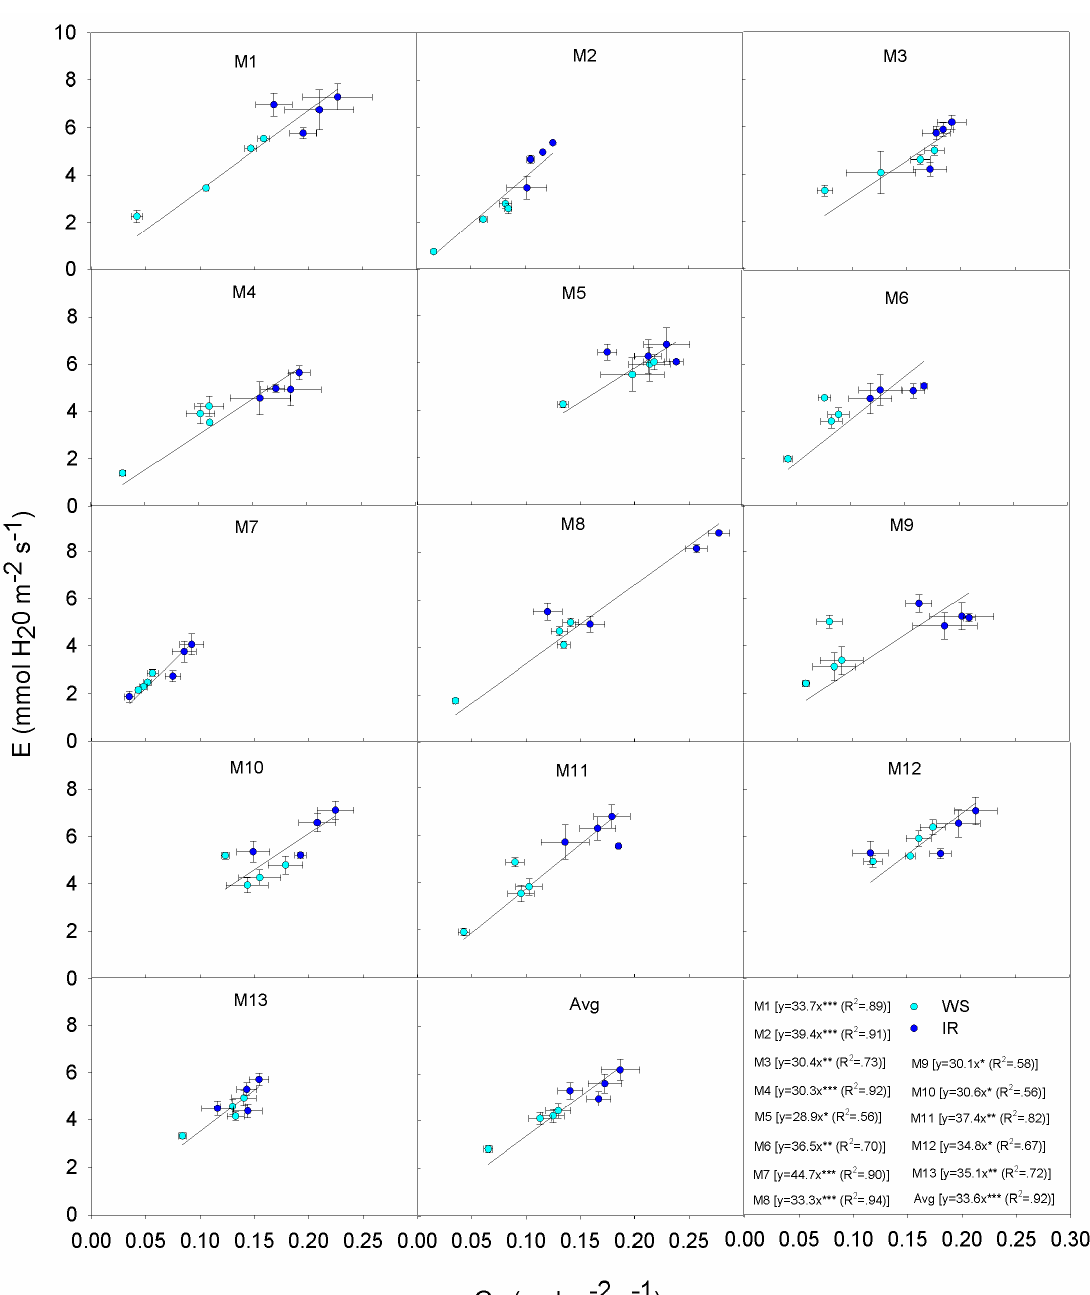
Figure 5. Relationships between stomatal conductance (Gs) and transpiration rate (E) of Miscanthus genotypes under rainfed (WS) and irrigated (IR) conditions in 2014 (the second year following planting). Significant slopes per p ≤ 0.05 (*), p ≤ 0.01 (**), p ≤ 0.001 (***), and not significant (ns). The slope of the genotypic averages in E and P N indicated a rate of change of 4.47 μ mol CO 2 m − 2 s − 1 increase for every 1.0 mmol H 2 O m − 2 s − 1 of E (Figure 6). All genotypes, except M12 and M13, had significant slopes and R 2 varied from 0.50 in genotype M3 to 0.88 in genotype M2. Genotypes M5 and M7 had the narrowest data distribution but clustered at the upper and lower range of E values, respectively. The greatest slope was from genotype M4 (4.79 μ mol CO 2 m − 2 s − 1 ), and the lowest slope from genotype M8 (3.76 μ mol CO 2 m − 2 s − 1 ) which also showed the widest data distribution.